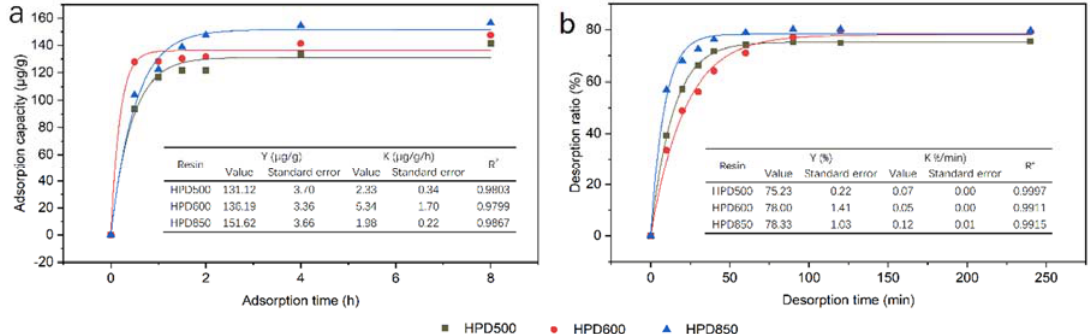
Figure 2. The adsorption kinetics curves ( a ) and desorption kinetics curves ( b ) for aucubin on HPD500, HPD600 and HPD850.